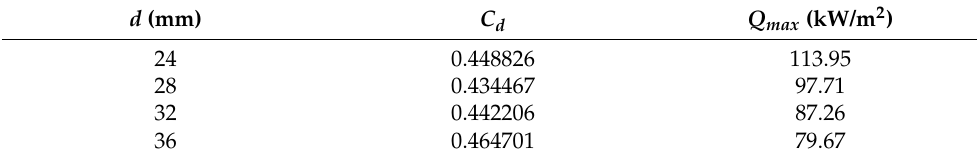
Figure 19. Initial pressure and heat flux of forebodies with different diameters d : ( a ) pressure; ( b ) heat flux. Table 11. Comparison of initial total drag coefficient and peak heat flux of the forebody.